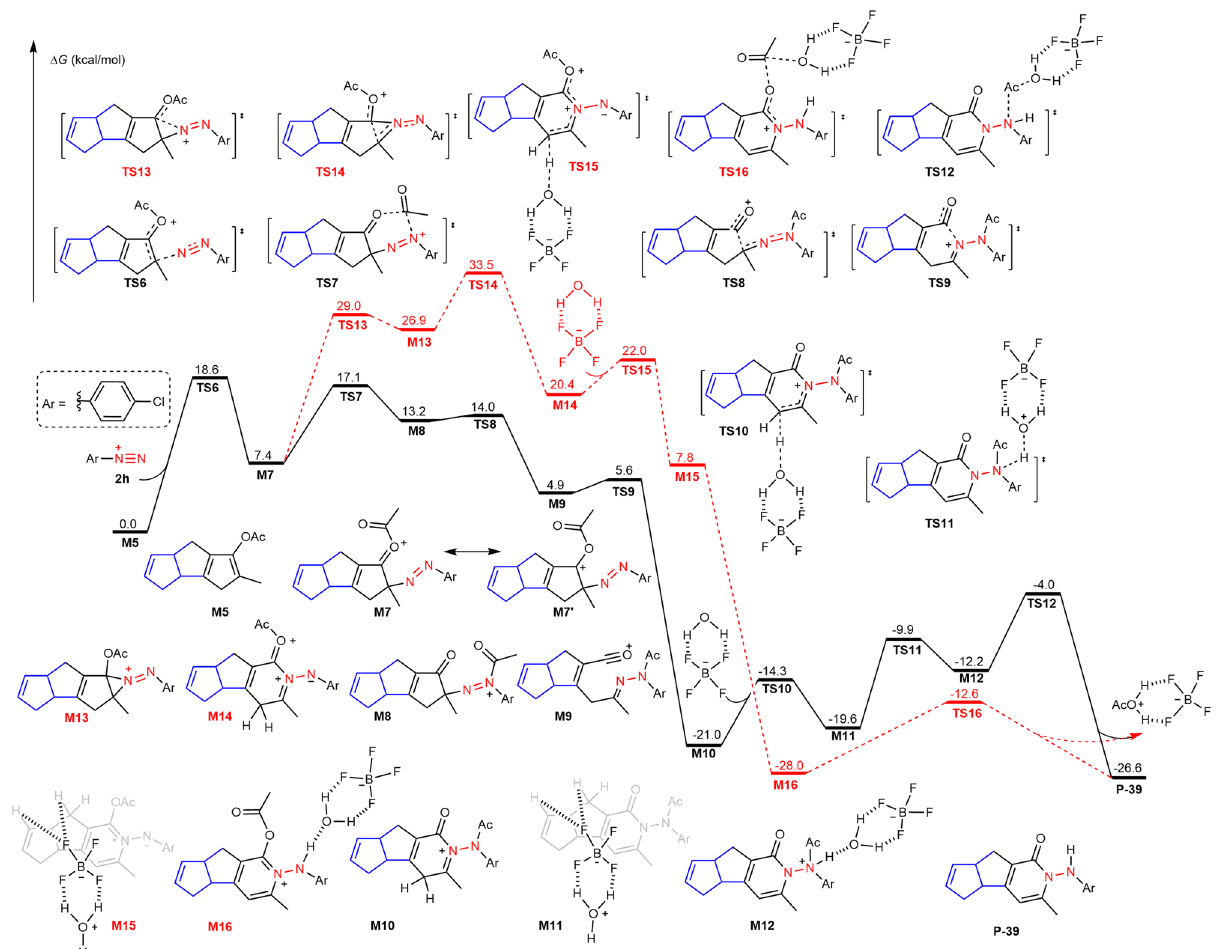
Fig. 9 | Calculated free energy pro fi les for the cyclization of aryldiazonium salt and intermediate 3 H -cyclopenta[ a ]pentalen-1-yl acetate M5. The relative free energies are computed at the M06-L/def2-TZVPP/SMD dichloroethane //M06-L/def2-SVP/SMD dichloroethane